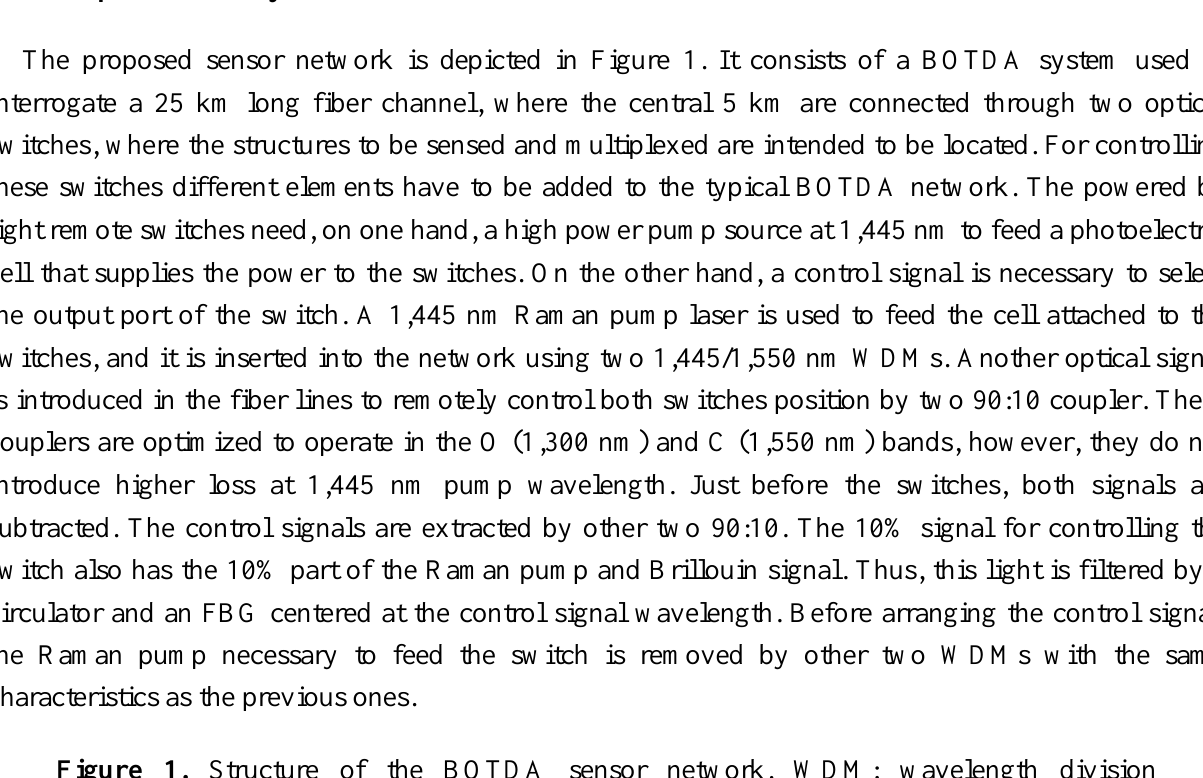
Figure 1. Structure of the BOTDA sensor network. WDM: wavelength division multiplexer; PPC: photoelectric cell; OC: optical control; LS: Laser Source; 1,445: 1,445 nm Raman